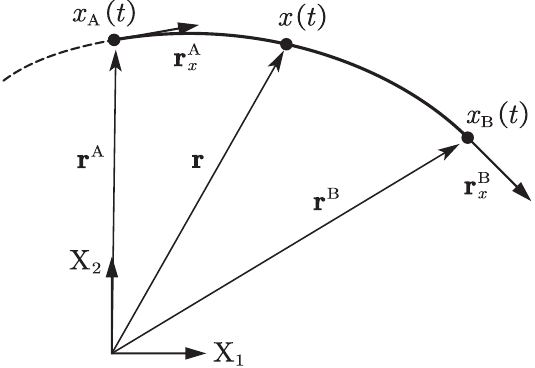
Figure 2. Arbitrary Lagrange–Euler absolute nodal coordinate formulation (ALE-RANCF) beam element model (X 1 and X 2 are axes of the global coordinate